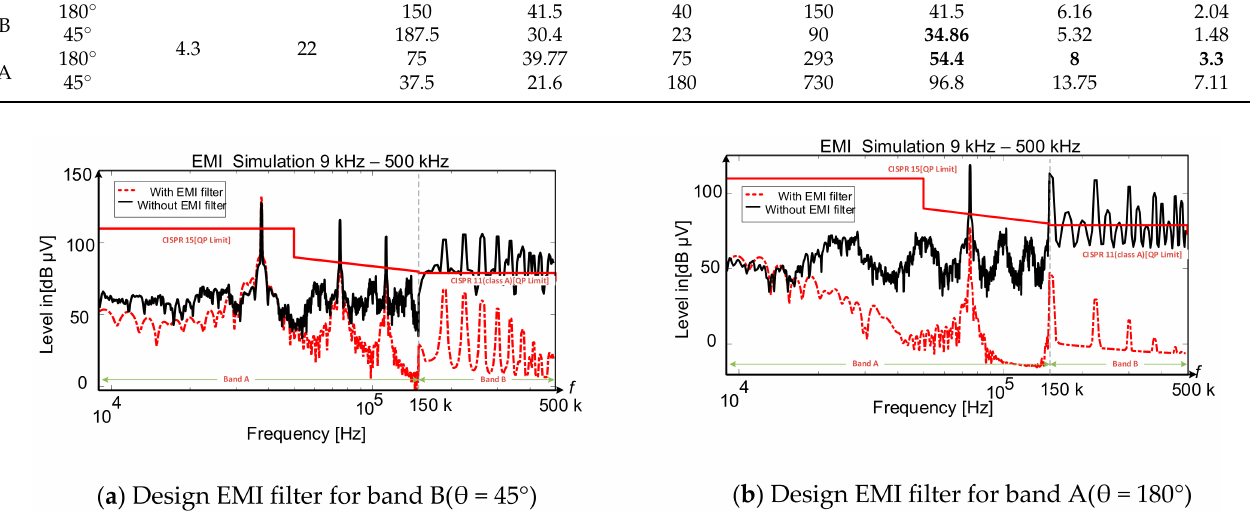
Figure 12. EMI simulation approach for two-unit interleaved CCM at f sw = 37.5 kHz based on Table